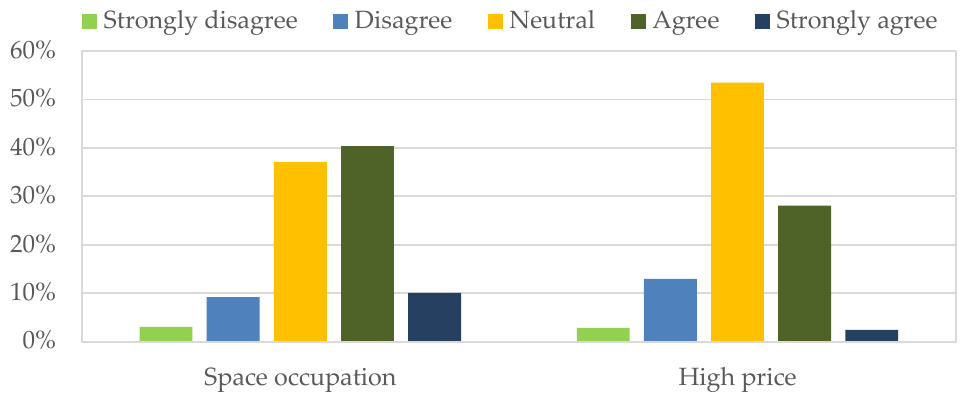
Figure 4. Consumers’ perception about the disadvantages of HPWHs. Compared with the high price of HPWHs, large space occupation was a concern of most respondents. Respondents were asked what they would do with an HPWH if it had been installed on the balcony (covering approximately 1 m 2 ) when they moved into a new house. Only 46.5% of the respondents chose to retain and use the HPWH, 22.9% chose to buy another type of water heater, and 10.8% wanted to remove and sell the HPWH as they did not like